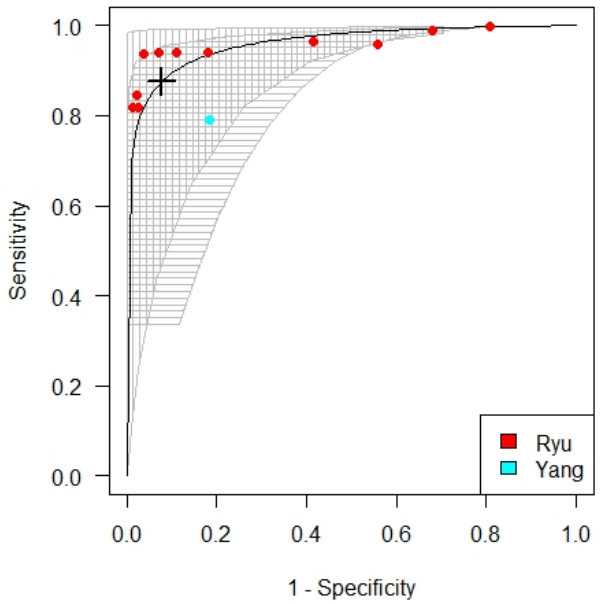
Figure 6. SROC curve for the optimized troponin T cut-off for patients on dialysis.